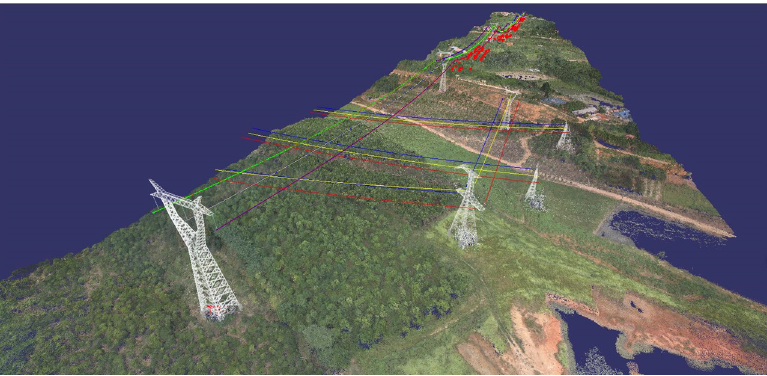
Figure 11. Diagram of Ground 3D Point Clouds and Power Lines within the Power Line Corridor.